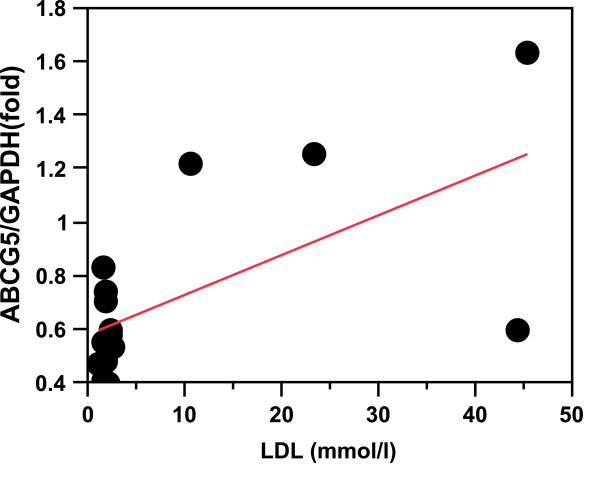
ABCG5expression in SUS liver relative to plasma LDL levels. r2 = 0.48; P < 0.008.